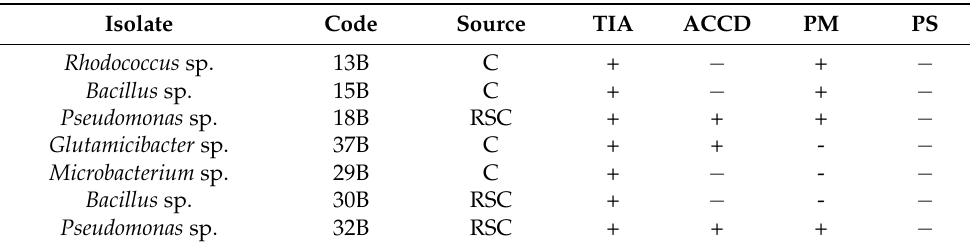
Table 5. Screening of representative plant growth-promoting traits in selected bacterial isolates dispersed along of fungal